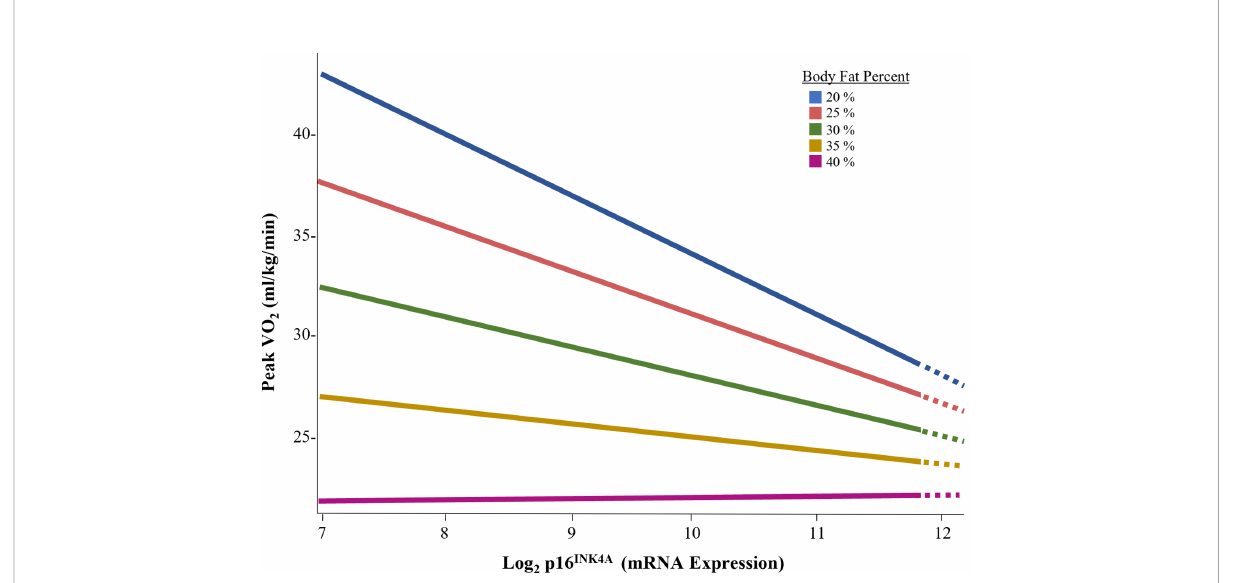
FIGURE 4 Association of p16 INK4A expression and exercise capacity by body fat percent in female